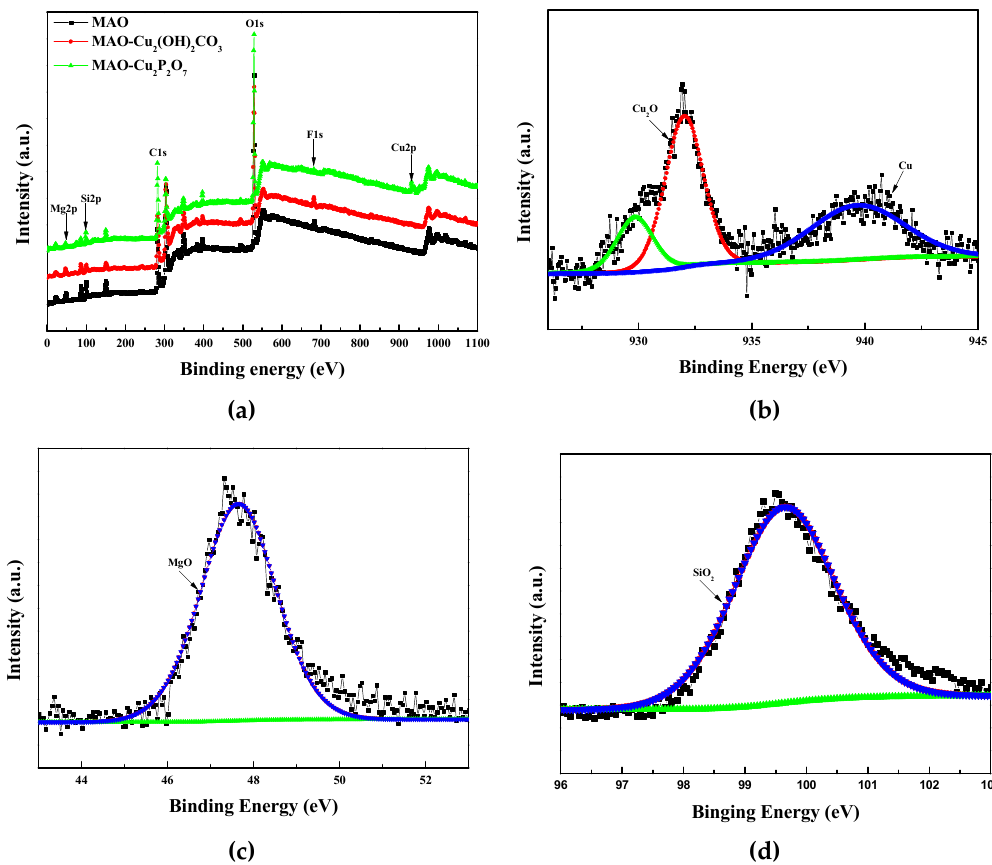
Figure 4. ( a ) XPS survey spectra of three MAO coatings, ( b ) Cu2p, ( c ) Mg2p and ( d ) Si2p typical high-resolution XPS spectrum of MAO–Cu 2 CO 3 (OH) 2 ·H 2 O coatings.